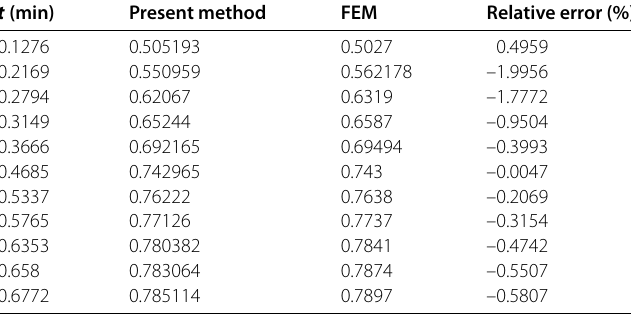
Figure 5 Relationship between t and θ in x d = 9 mm.